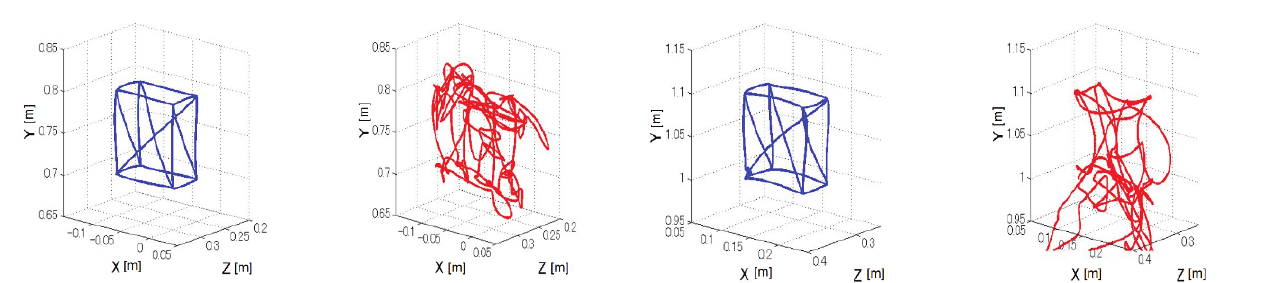
Figure 12. Task space trajectory of the tip of the L-shaped tool during the test movement, after motor babbling was performed first without tool,